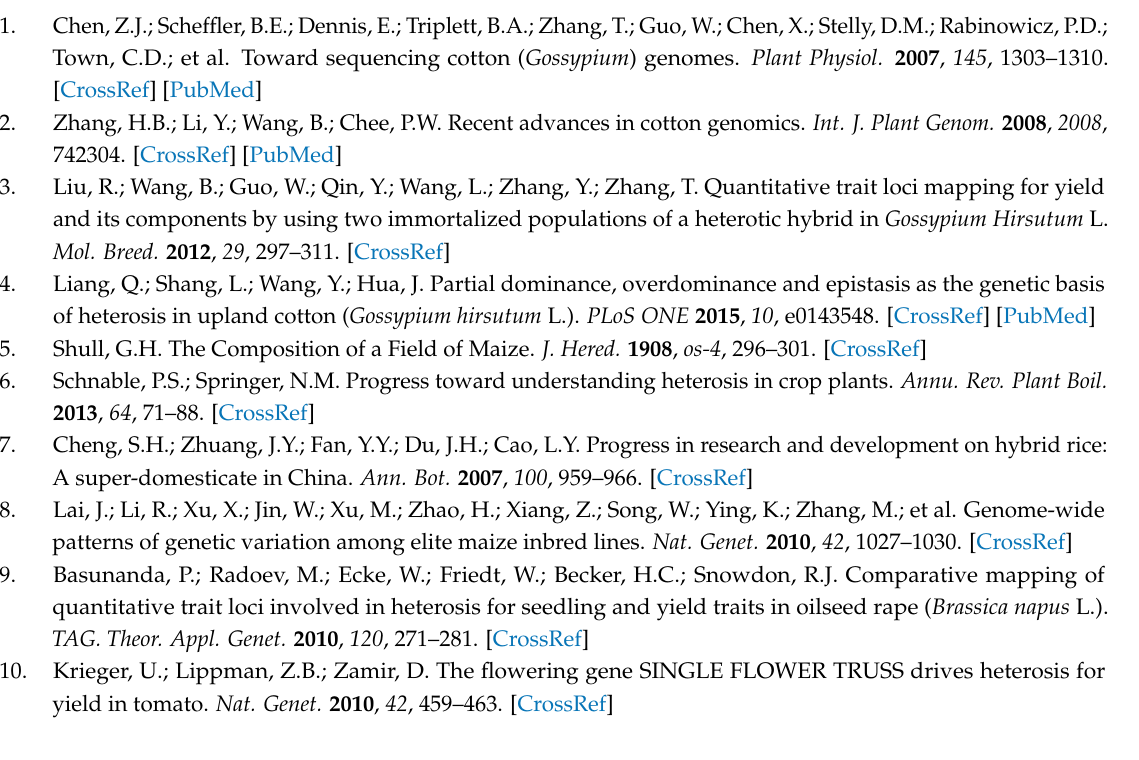
different substitution types in 9053 and sGK9708. Figure S2: Numbers of genes contained the polymorphic SNPs and InDels. Blue circle indicated genes including SNPs, and orange circle represented genes containing InDels. Figure S3: The heatmap of gene expression for Cluster 1–3. The expression levels of genes were calculated by log 2 (FPKM) values and the color bar denoted the gene transcript abundance. Red indicated high expression level, and green indicated low expression level. Figure S4: The heatmap of gene expression for Cluster 4–6. The expression levels of genes were calculated by log 2 (FPKM) values, and the color bar denoted the gene transcript abundance. Red indicated high expression level, and green indicated low expression level. Figure S5: The heatmap of gene expression for Clusters 7–10. The expression levels of genes were calculated by log 2 (FPKM) values and the color bar denoted the gene transcript abundance. Red indicated high expression level, and green indicated low expression level. Figure S6: Gene ontology classification of genes containing polymorphic DNA between 9053 and sGK9708. Different color represents different ontology, cellular component, molecular function and biological process. The mainly results of gene ontology analysis were shown. Figure S7: Physical map of SNPs and InDels which overlapped with the previous reported QTLs about LP and BW in D subgenome. The red line indicated the InDels, the QTL intervals of GWAS study were replaced by the pink color on the chromosomes and the green and brown bar indicated the LP QTLs and BW QTLs producing by QTL mapping study. Table S1: Comparison of agronomic traits among three accessions. Table S2: Summary variation information of each accession. Table S3: SNPs variants in gene region of 9053 and sGK9708. Table S4: Variations detected between 9053 and sGK9708. Table S5: The significant enriched GO terms of genes ( p -value = 0.05). Table S6: The QTLs of LP and BW overlapped with the genes containing SNPs/InDels in previous linkage mapping study. Table S7: The QTLs of LP and BW overlapped with the genes containing SNPs/InDels in previous GWAS study. Table S8: The homologous annotation of the genes overlapped with the